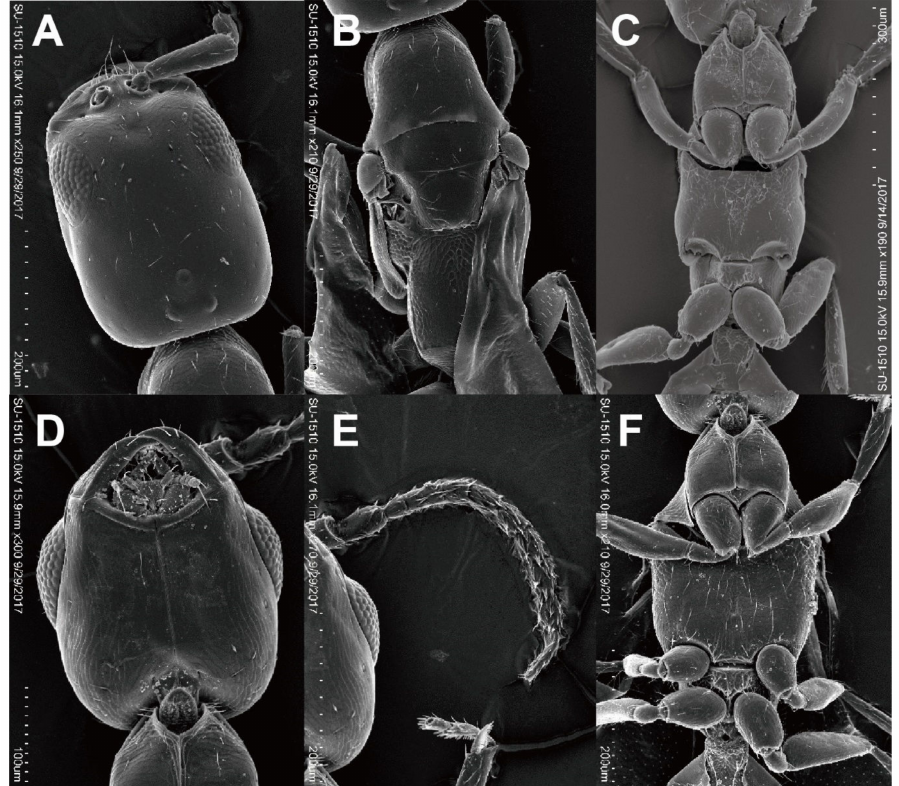
Figure 6. Cephalonomia formosiensis sp. nov. ( A–C ) Macropterous adult female. ( A ) Head, dorsal view. ( B ) Mesosoma, dorsal view and ( C ) ventral view. ( D–F ) Adult Male. ( D ) Head, ventral view. ( E ) Antenna, dorsal view. ( F ) Mesosoma, ventral